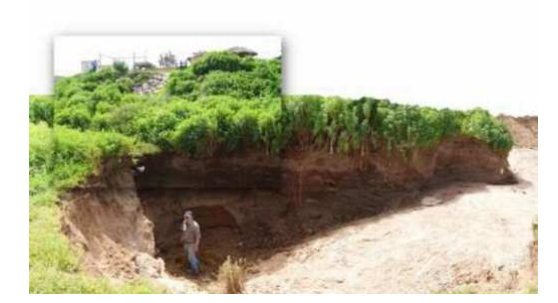
Fig. 5. Risk and vulnerability zones in the Campillo (taken from MEZA-UABC